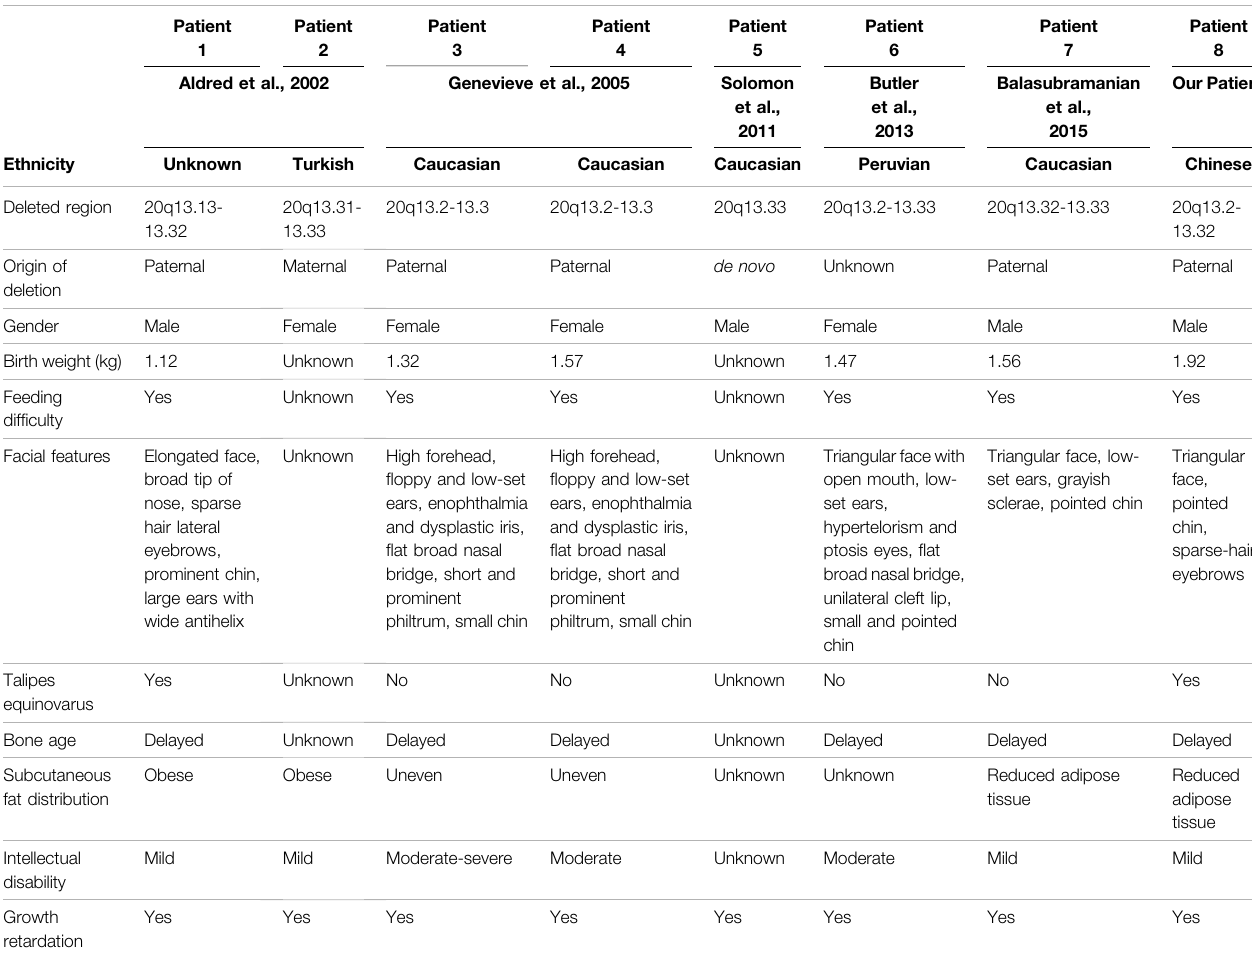
TABLE 1 | Clinical features of patients with deletion around 20q13.32 containing GNAS